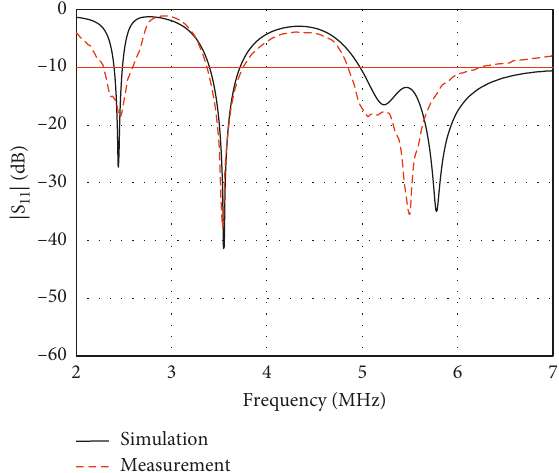
Figure 11: Simulated and measured | S